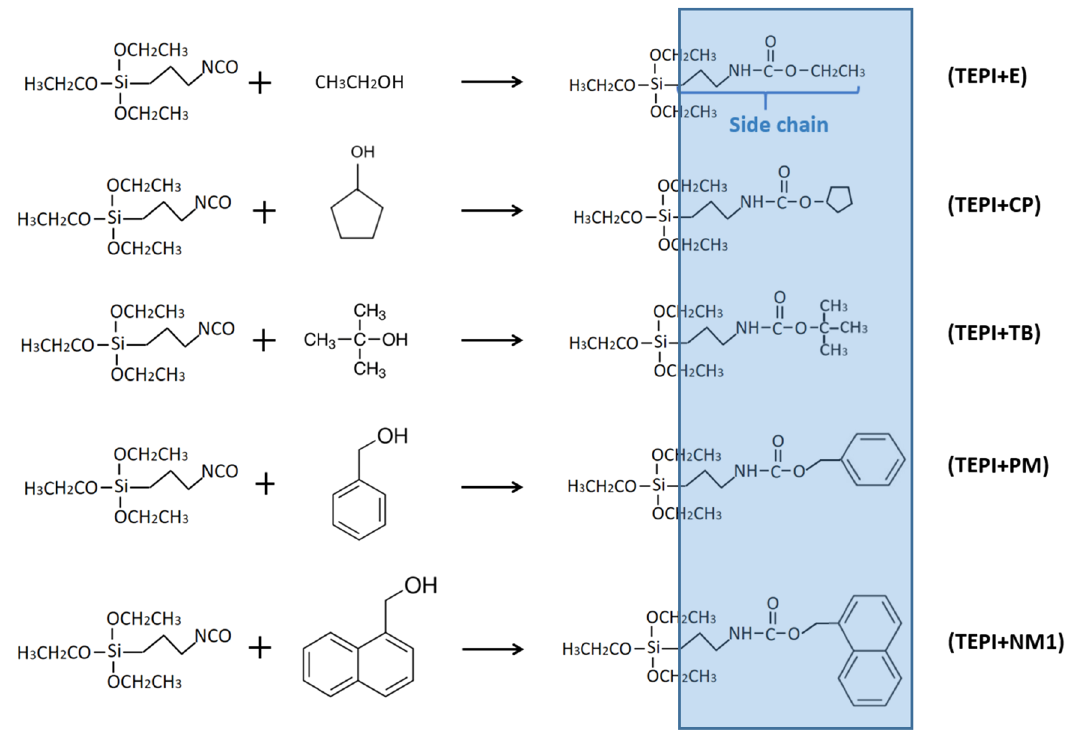
Figure 4: Scheme of reaction of TEPI with di ff erent alcohols.